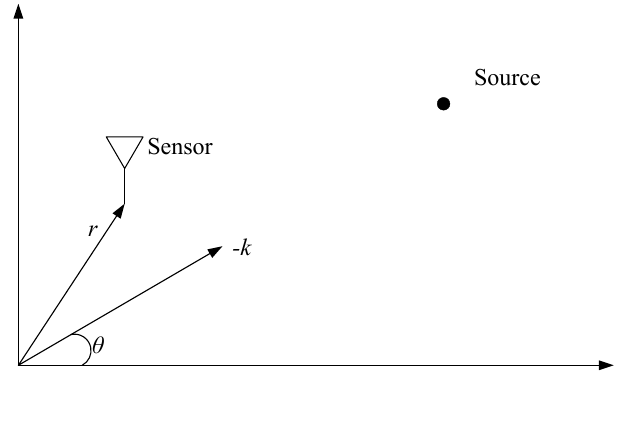
Figure 5. One-sensor one-source